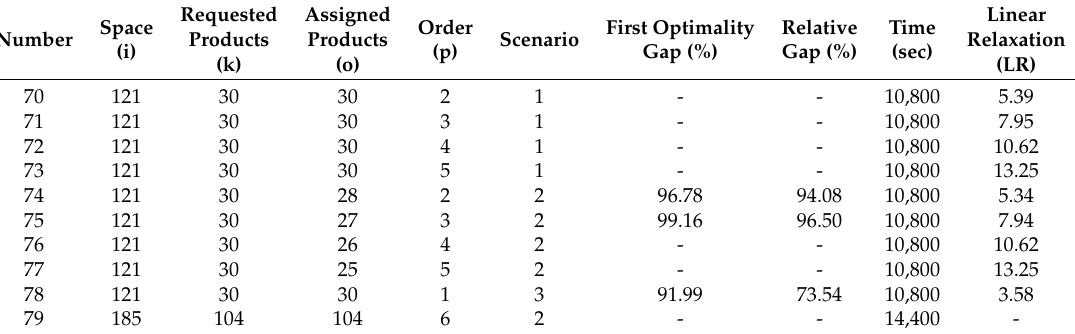
Table 4. Results for large size